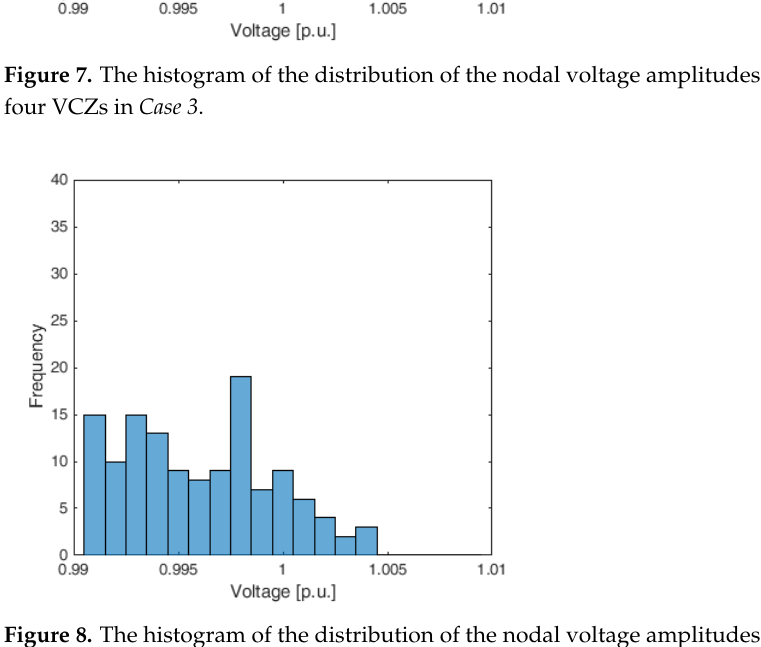
Figure 8. The histogram of the distribution of the nodal voltage amplitudes for the partitioning in seven VCZs in Case 3